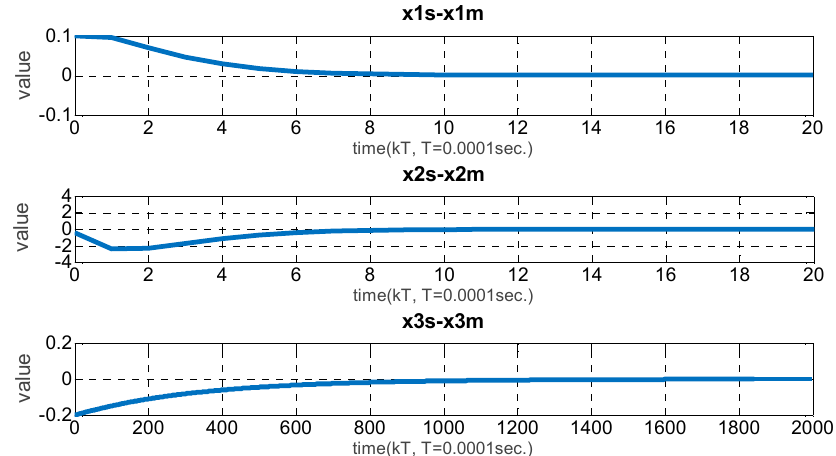
Figure 3. The response of the error function of the master – slave chaos system.